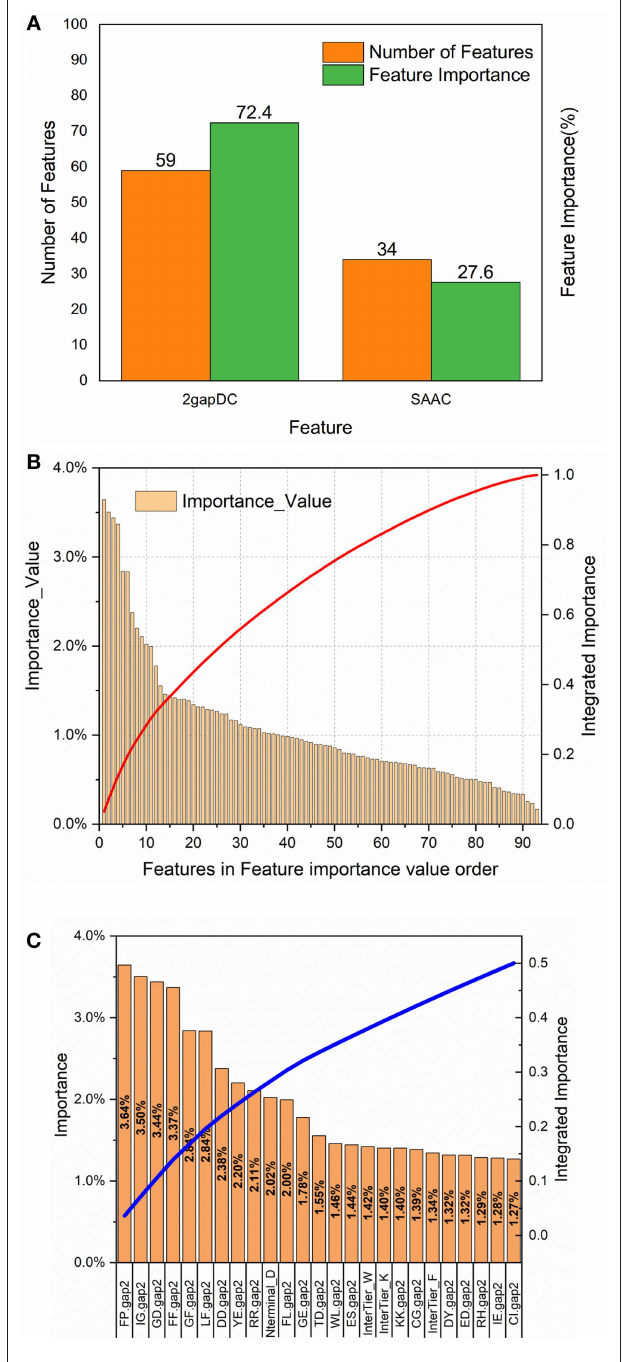
FIGURE 3 | Feature importance analysis of random forests sub-Golgi classifier, rfGPT _4: (A) importance of feature types (B) the ranking orders of 93 features for rfGPT_4 and their integrated importance (red line), and (C) the importance of the top 25 features, which accounted for 50% of the integrated importance (blue line). The A 1 A 2 .gap2 means the composition of dipeptide A1A2. A1 or A2 is one of the 20 amino acid residues. Nterminal_D means the composition of amino acid residues D (aspartate) in NH 2 -terminal of protein sequence. InterTier_K, interTier_W, and interTier_F mean K(lysine), W(tryptophan), and F(phenylalanine) amino acid residues composition of the inter-tier between NH 2 -terminal and COOH-terminal of protein